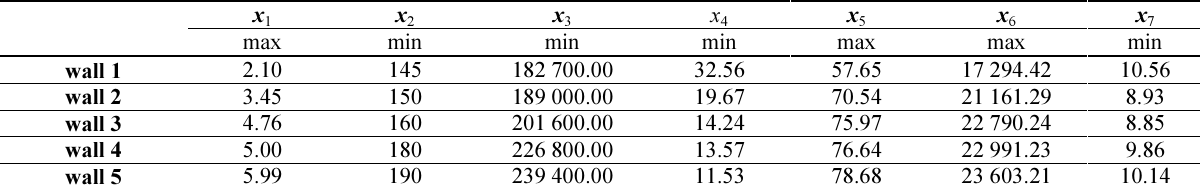
Table 3. MOORA applied on 5 wall alternatives with 7